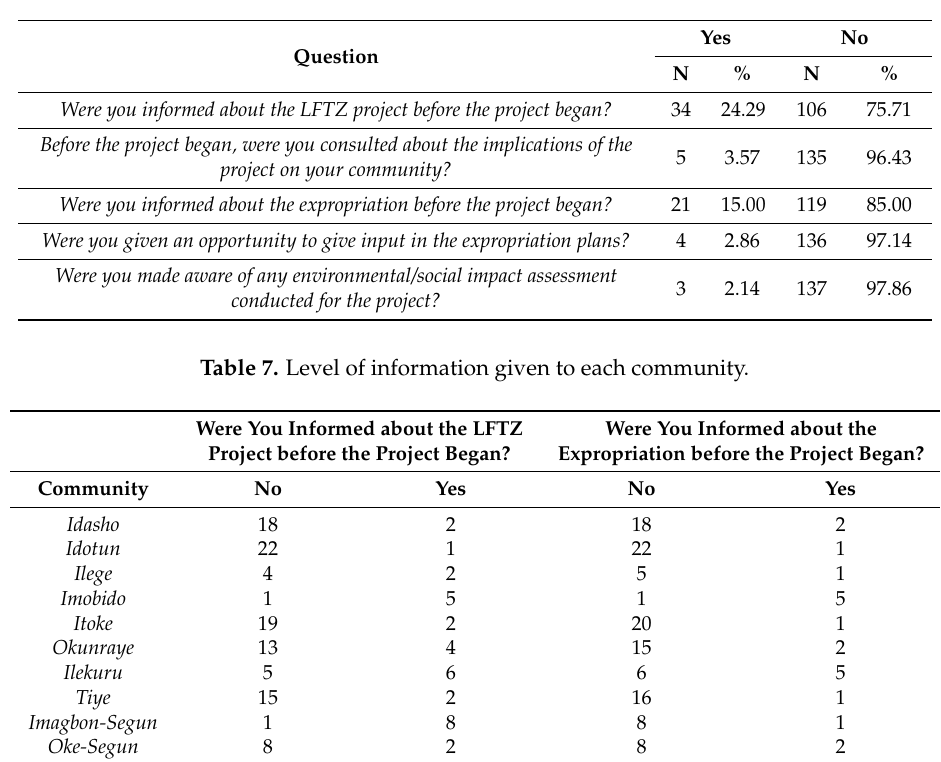
Table 6. Participation and information of local communities affected by the LFTZ.